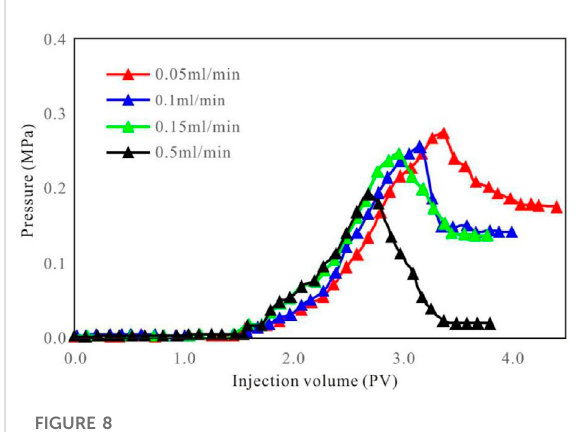
FIGURE 8 Variation of core pressure under different injection rates.